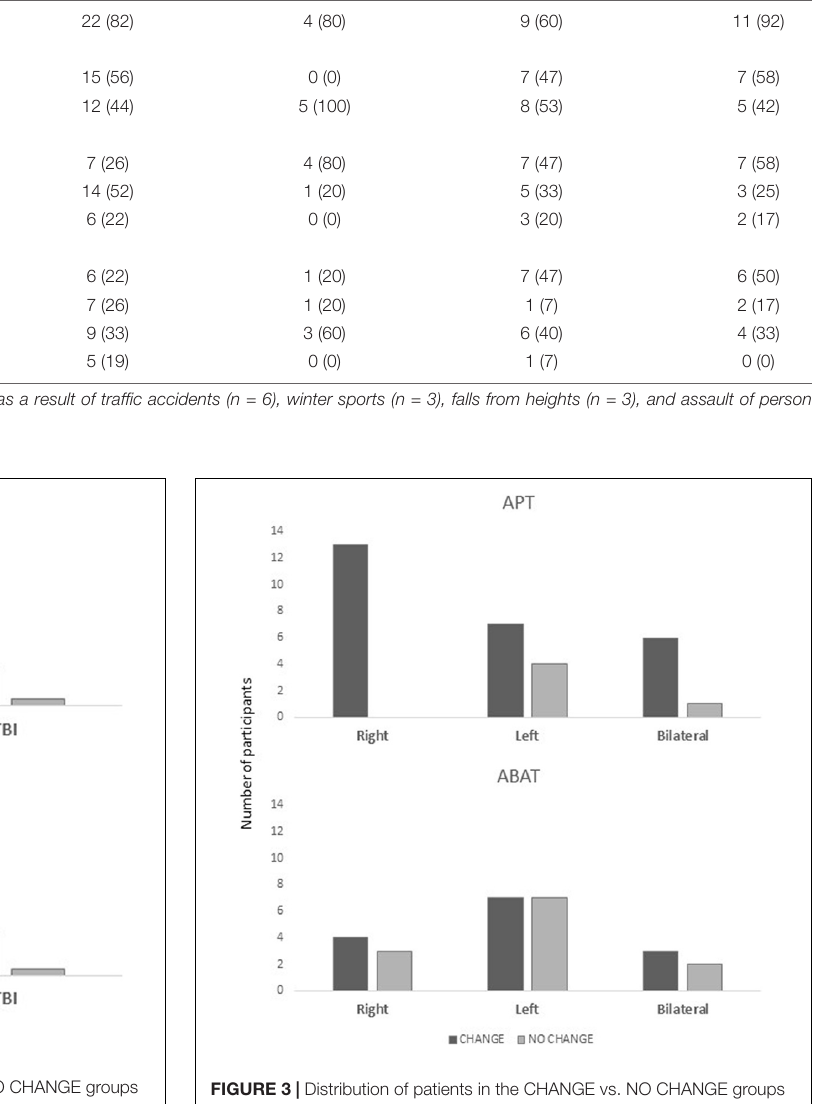
FIGURE 3 | Distribution of patients in the CHANGE vs. NO CHANGE groups split for injury localization (right, left, and bilateral) and treatment (APT, Attention Process Training; ABAT, Activity-Based Attention Training), where the y-axis indicates the number of patients for each